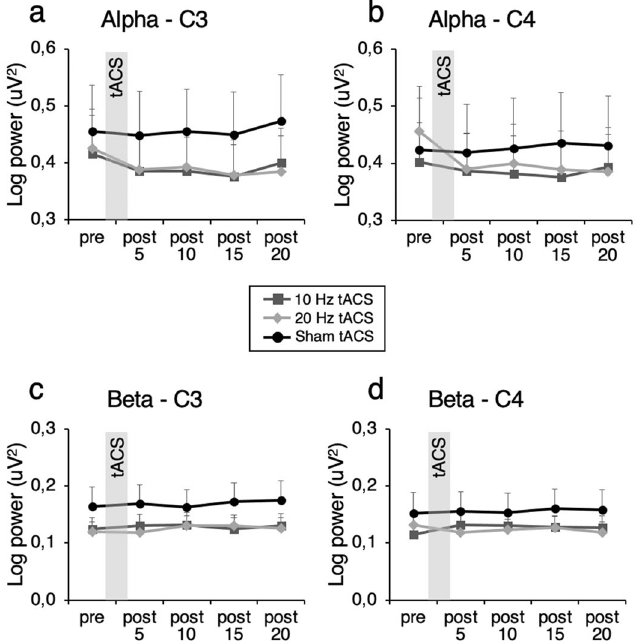
Figure 1. Effects of tACS on alpha and beta oscillations. Log-transformed alpha power at electrode ( a ) C3 and ( b ) C4 following stimulation. Log-transformed beta power at electrode ( c ) C3 and ( d ) C4 following stimulation. Error bars represent SEM.